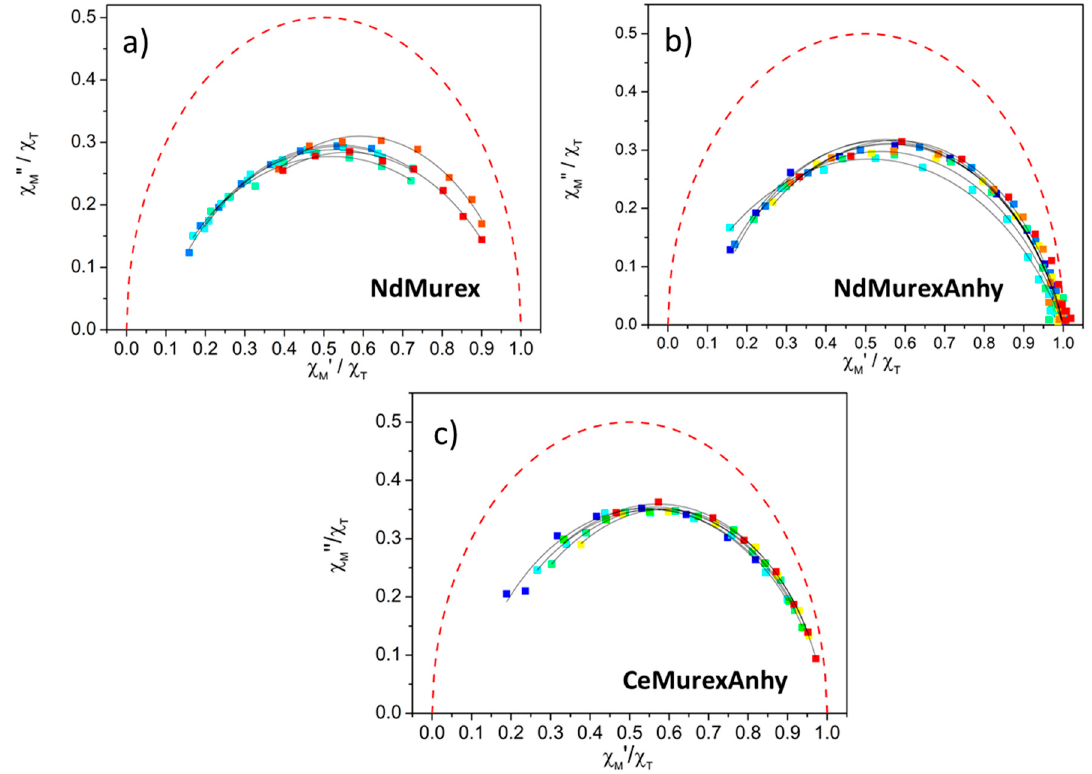
Figure 6. Cole-Cole plots measured for temperatures from 1.8 (blue) to 5 K (red) and for NdMurex (H dc = 1200 Oe, a ), NdMurexAnhy (H dc = 1200 Oe, b ), and CeMurexAnhy (H dc = 400 Oe, c ) with selected fits and simulation of the ideal distribution of the magnetic relaxation as red curve.